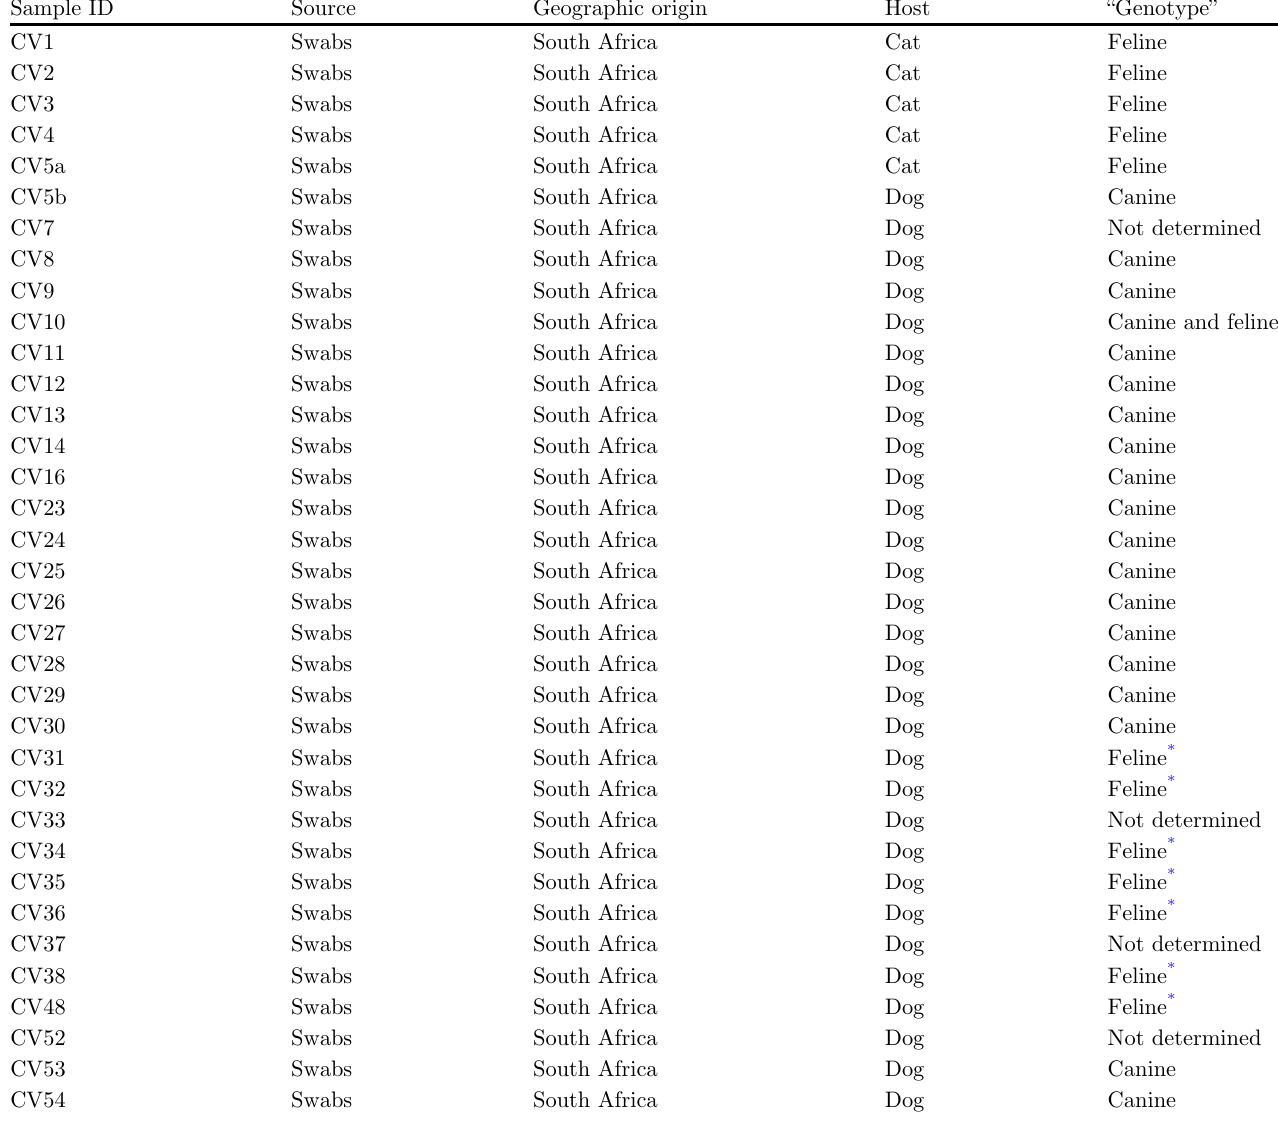
Table 3. Details on two distinct 28S rDNA sequence variants ( “ canine ” and “ feline ” ) de fi ned from non-invasive anal swabs collected from cats and dogs infected by Dipylidium caninum in South